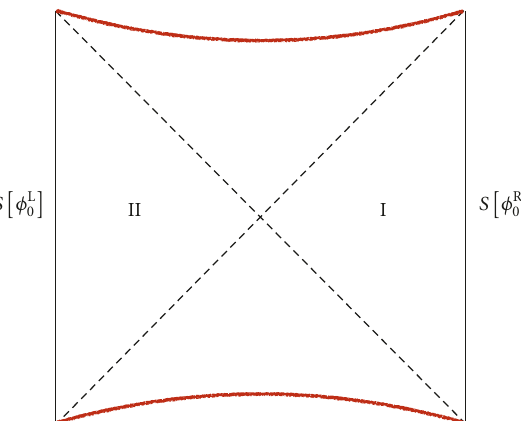
Figure 1: The Penrose diagram corresponding to an eternal black hole in AdS. The left and the right boundaries are where the dual CFT is defined, which are schematically denoted by 𝑆[𝜙 0